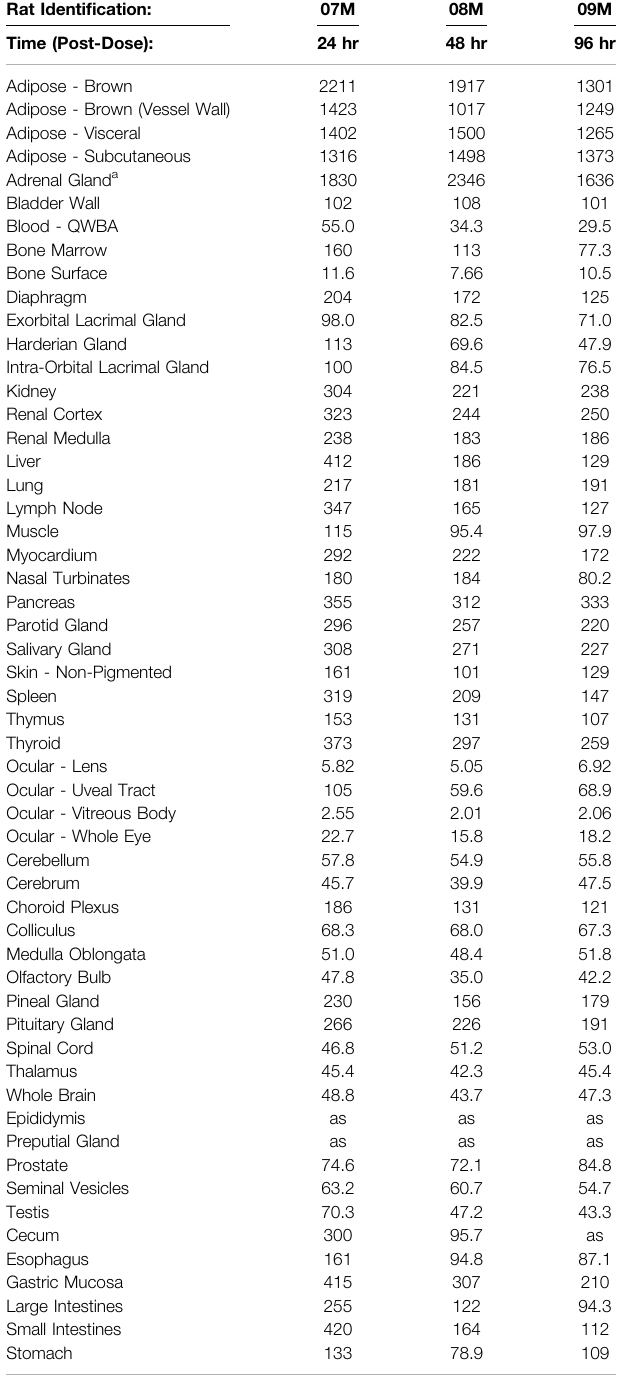
TABLE 3 | Radioactivity concentrations ( μ g equivalents/g) determined by quantitative whole-body autoradiography in tissues and blood through 96 h after daily, multiple oral doses 1,2 of [ 14 C]PPI-1011 to Group 2 Sprague-Dawley male rats (Nominal Dose Levels: 100 μ Ci/kg and 100 mg/kg). Rat Identi fi